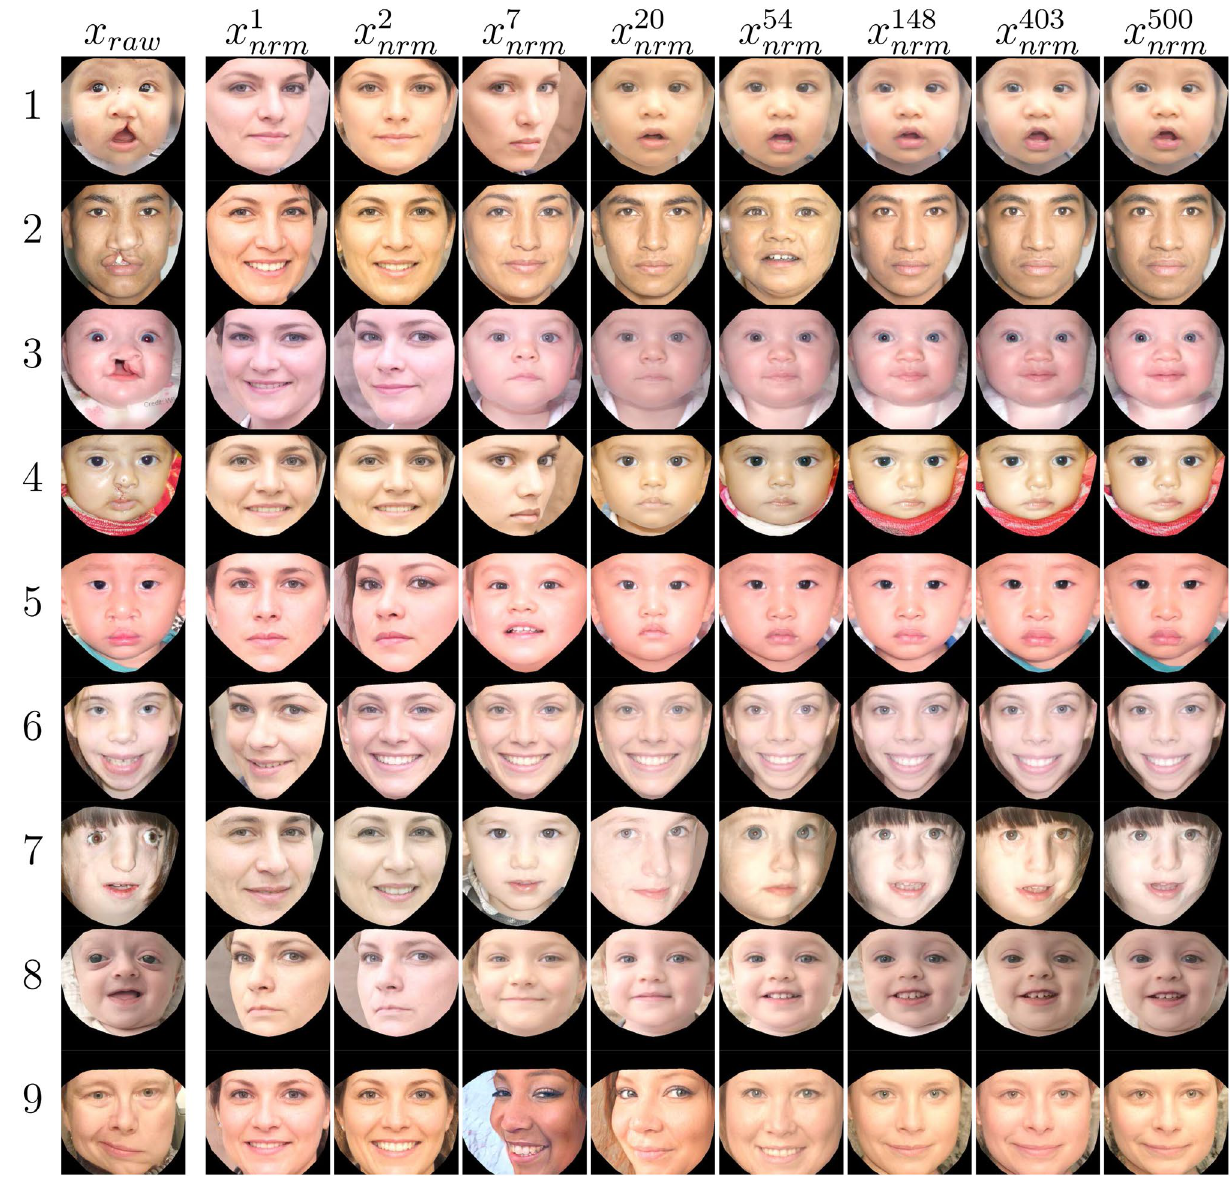
the iterations rounded to the nearest integer natural logarithm ( ln ( i ) ) for each iteration i between 0 and 500, respectively. The final column represents the optimal version out of 500 iterations, namely x nrm . References for images in column x raw : row 1 44 , row 2 45 , row 4 46 , row 5 47 , row 6 48 , row 8 49 , row 9 50 . All other images are duplicates or transformations created by the study